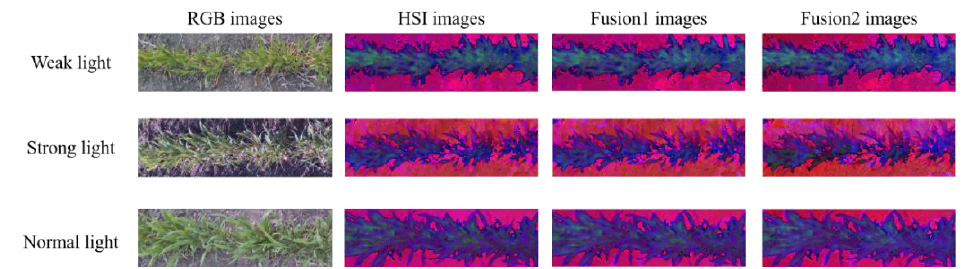
Figure 8. Image fusion results under different lighting conditions. Table 2. Entropy and cross-entropy of source image and fused images.